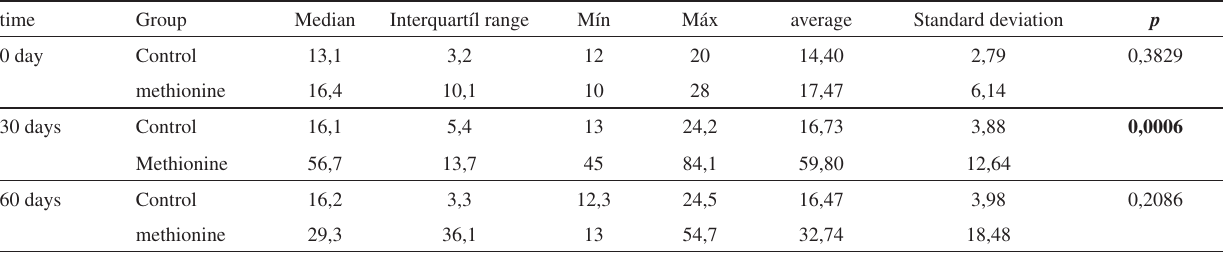
Table 5 - Plasma homocysteine levels